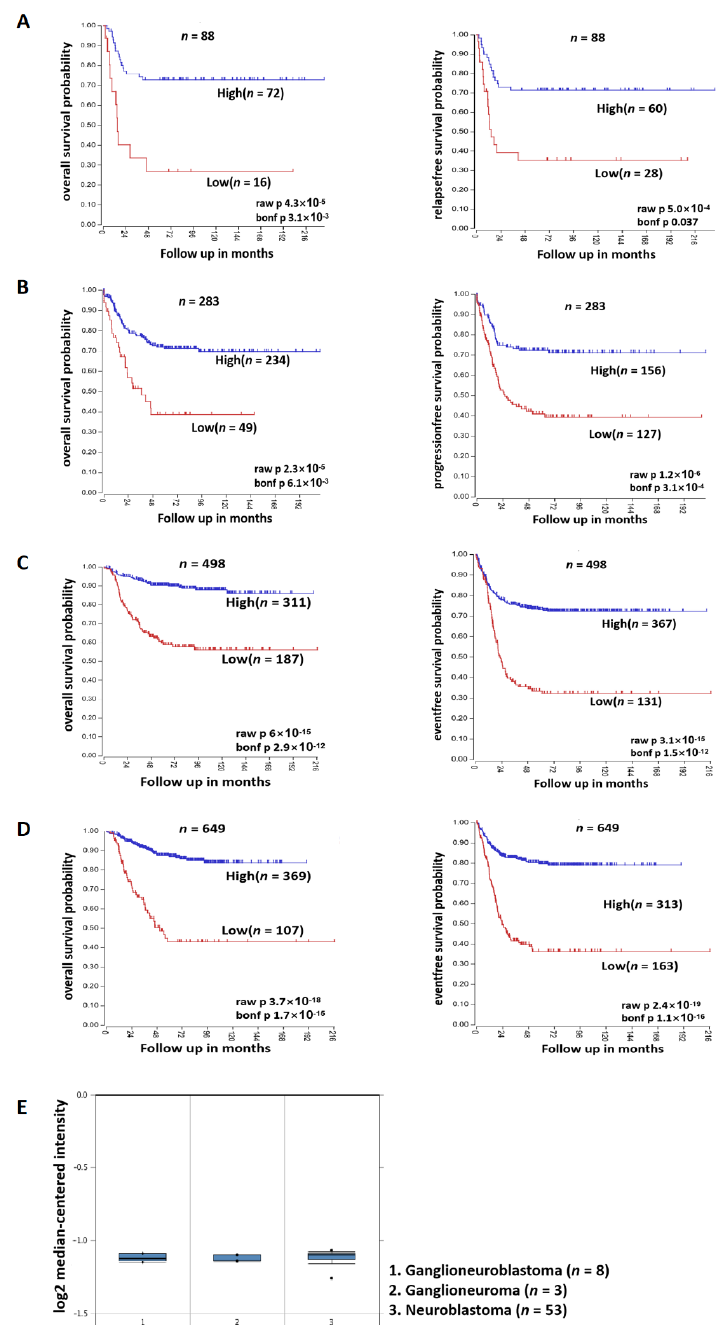
Figure 3. SOX4 has a positive correlation with the survival rate of patients with NB. Four datasets with different clinical samples ( A : 88 samples, B : 283 samples, C : 498 samples, and D : 649 samples)